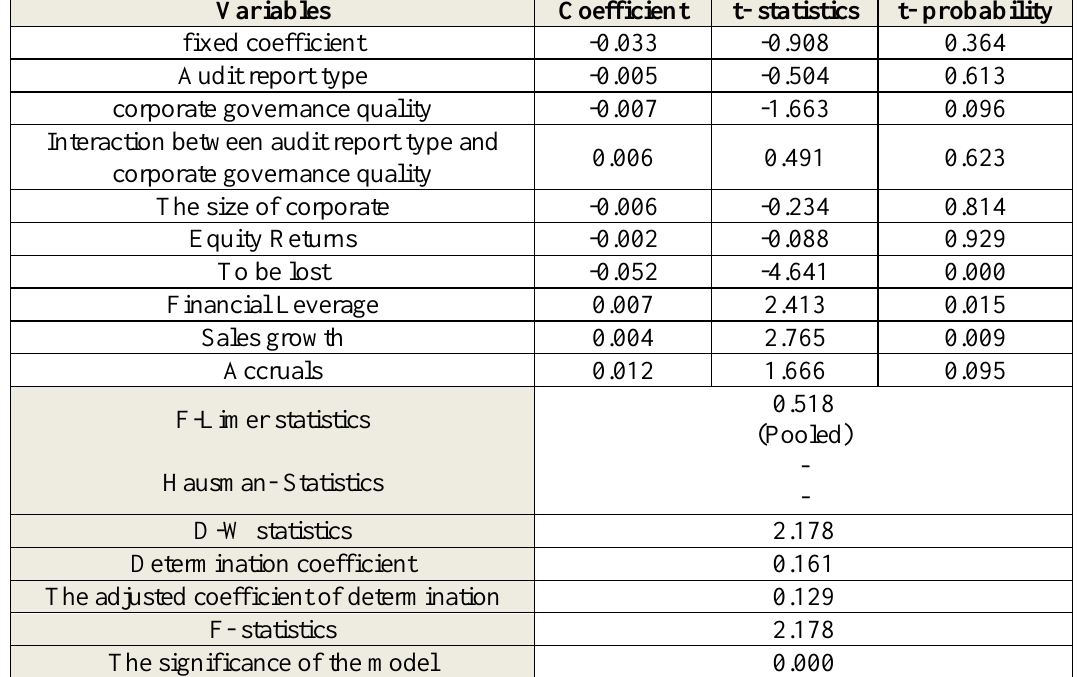
Table 5: Test results of the second